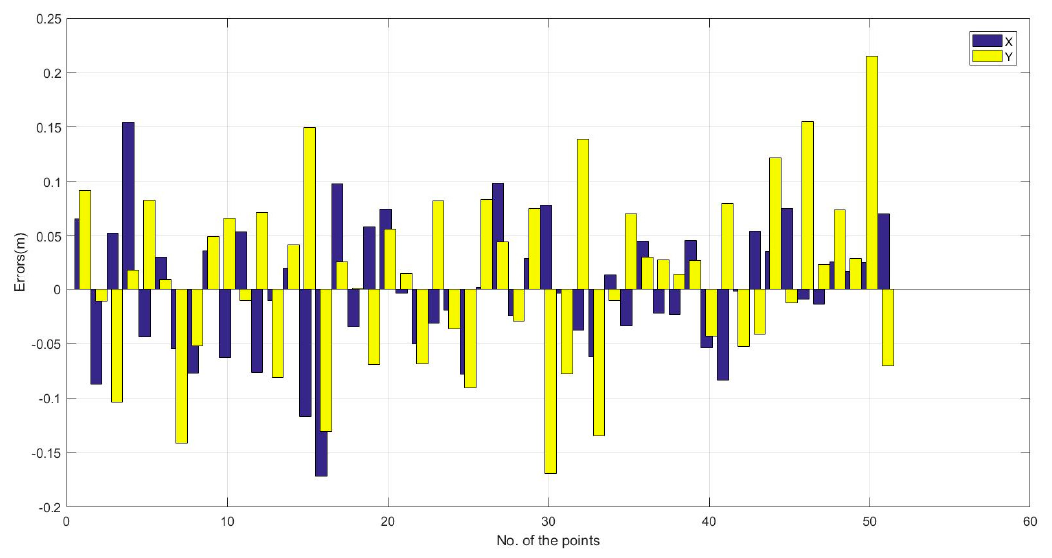
Figure 16. Difference between the coordinates of the orbit and the calculation results.